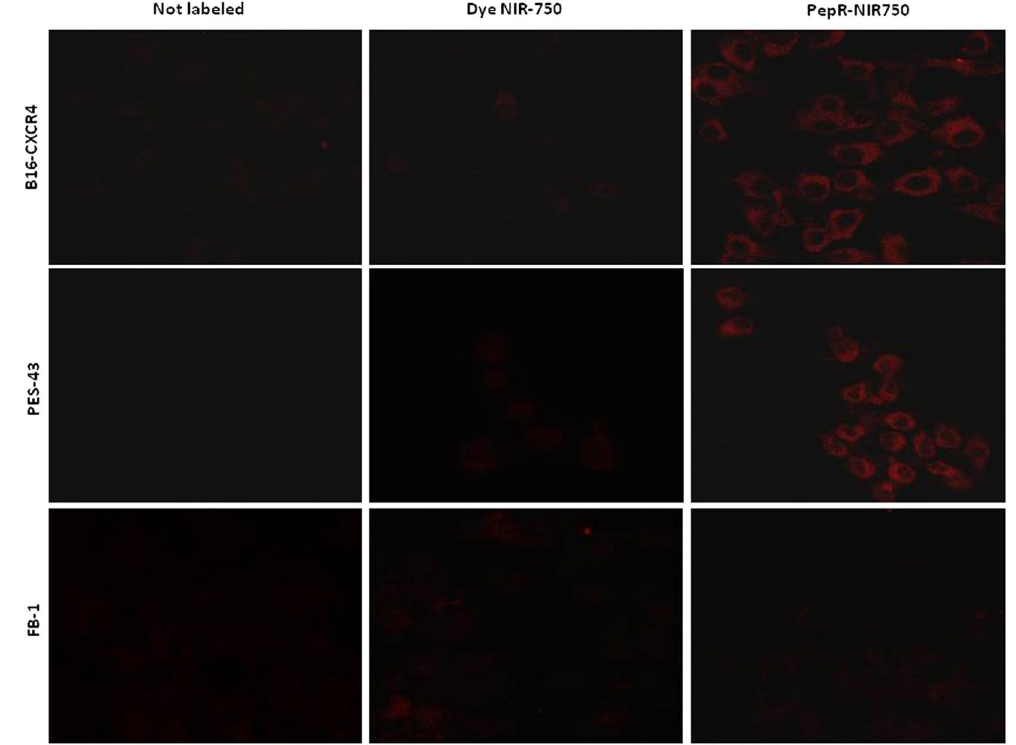
Figure 1. PepR-NIR750 specifically binds CXCR4 expressing cells. B16-CXCR4 and PES43 tumor cell lines expressing high CXCR4 levels and FB1 cells expressing very low CXCR4 levels were plated on glass coverslips and labeled with PepR-NIR750 or VivoTag-S 750 alone (100 nM) for 1 h at 37 °C; nuclei were labeled with DAPI and the fluorescence was observed by confocal microscope (LSM 510 Zeiss). PepR-NIR750 binds to